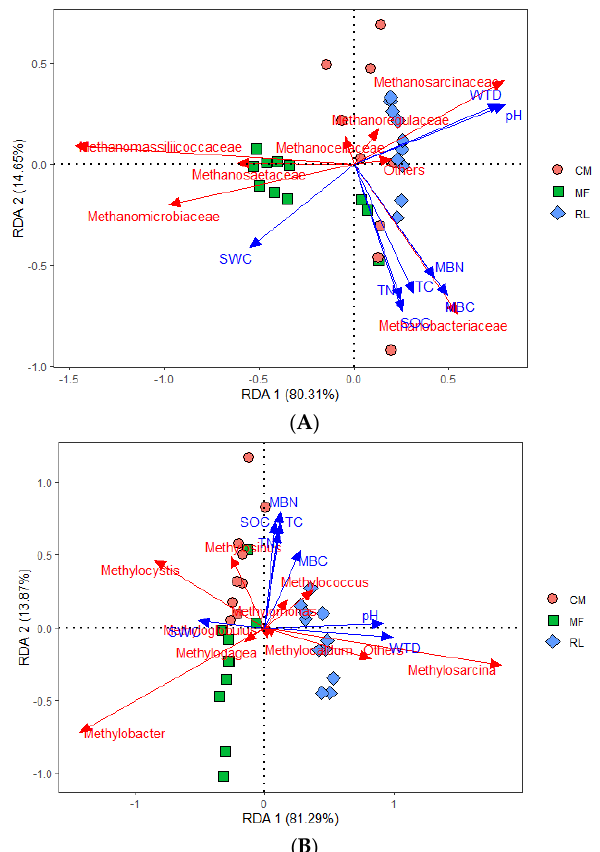
Figure 5. RDA ordination diagrams of methanogen ( A ) and methanotroph ( B ) community composition and environmental variables. MF, CM, and RL represent the three sampling sites of mudflat, Carex meadow, and reed land, respectively. Arrows point to variables associated with community composition, and the length of the arrows indicates the percentage of data explained by that variable. The following abbreviations indicate environmental factors: SWC: soil water content, MBC: microbial biomass carbon, MBN: microbial biomass nitrogen, SOC: soil organic carbon, TC: total carbon, TN: total nitrogen, WTD: water table depth.